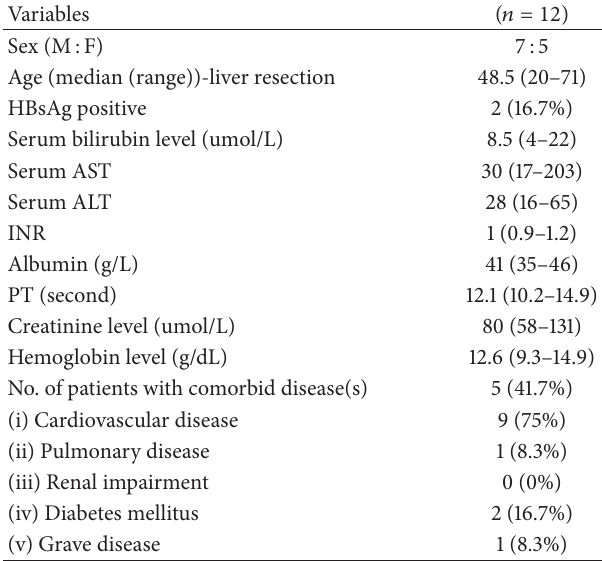
Table 1: Demographic data of patients before